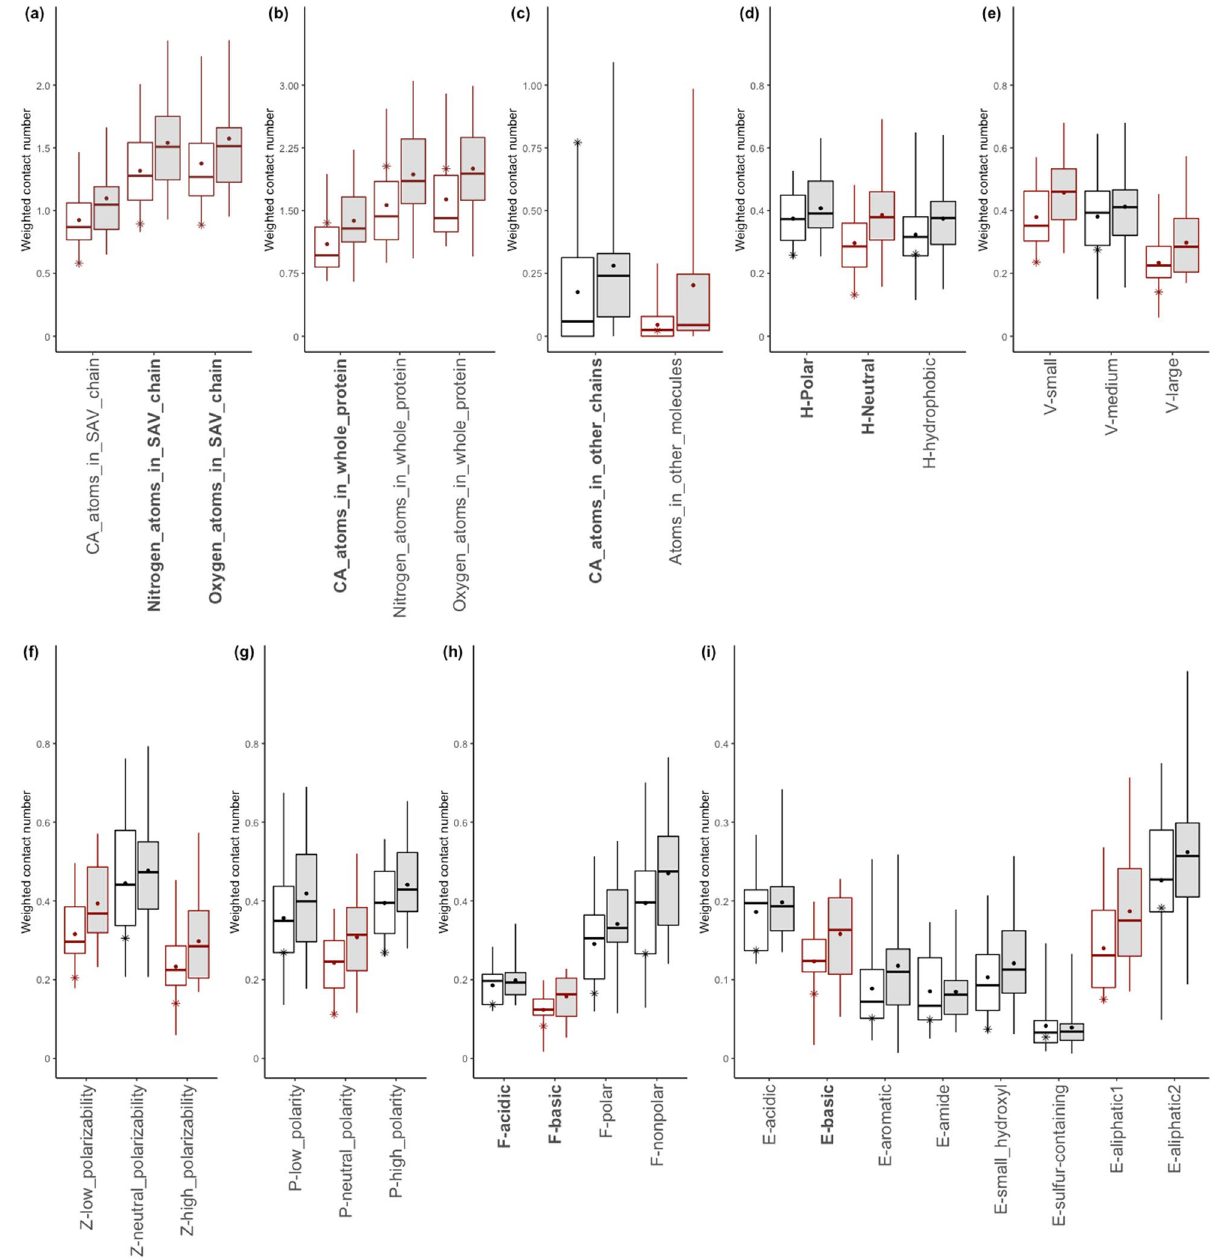
Figure 5. Boxplots of the microenvironment descriptors in the ASP that are altered to the TYR subgroup. All microenvironment descriptors are divided into nine groups: ( a ) atoms in the SAV chain; ( b ) atoms in whole protein; ( c ) atoms in other chains or molecules; ( d ) H -group; ( e ) V -group; ( f ) Z -group; ( g ) P -group; ( h ) F -group; and ( i ) E -group. The white and grey boxes represent the distribution of cancer-related and neutral SAVs. Red-framed boxes indicate that two sample z -testing revealed a significant difference between cancer- related and neutral SAVs, with a 95% confidence interval (z score > 1.96, p < 0.05). Labels of descriptors selected by the genetic algorithm are bolded in the x -axis. Star symbols denote the D227Y cases in